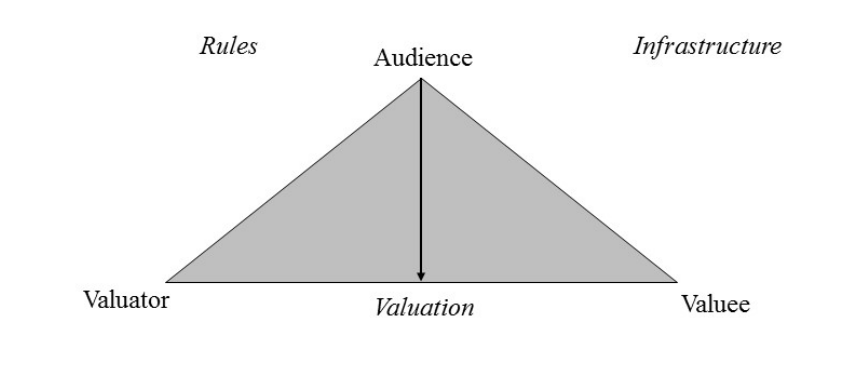
Figure 1 The valuation constellation Source: Authors’